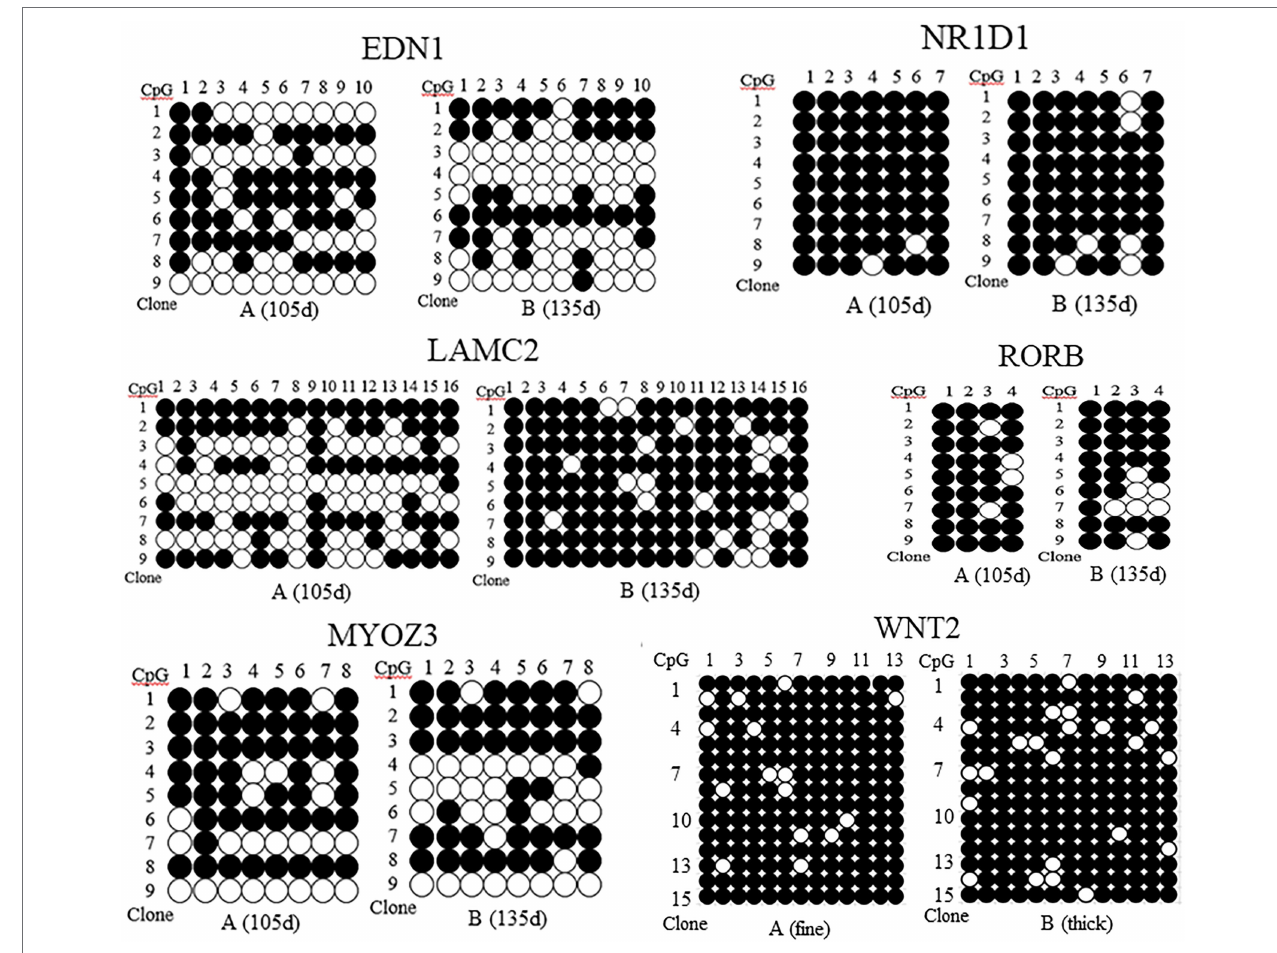
FIGURE 5 | Methylation patterns of EDN1, NR1D1, LAMC2, RORB, MYOZ3, and WNT2 gene in skin tissues of Super Merino sheep with different stages and fineness. ● , indicates methylation; ○ , indicates no methylation. (A) (fine), the extremely fine group; (B) (thick), the extremely thick